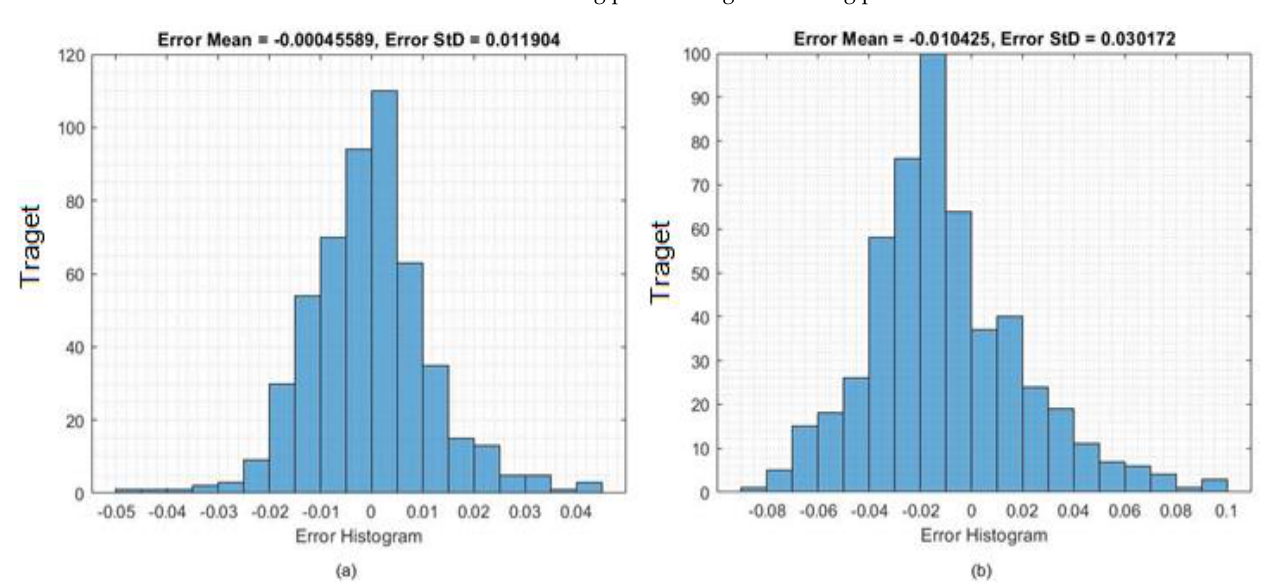
Figure 7. Histogram of the deep learning models ( a ) CNN-LSTM and ( b ) LSTM for predicting the Tesla stock market closing price during the training phase.